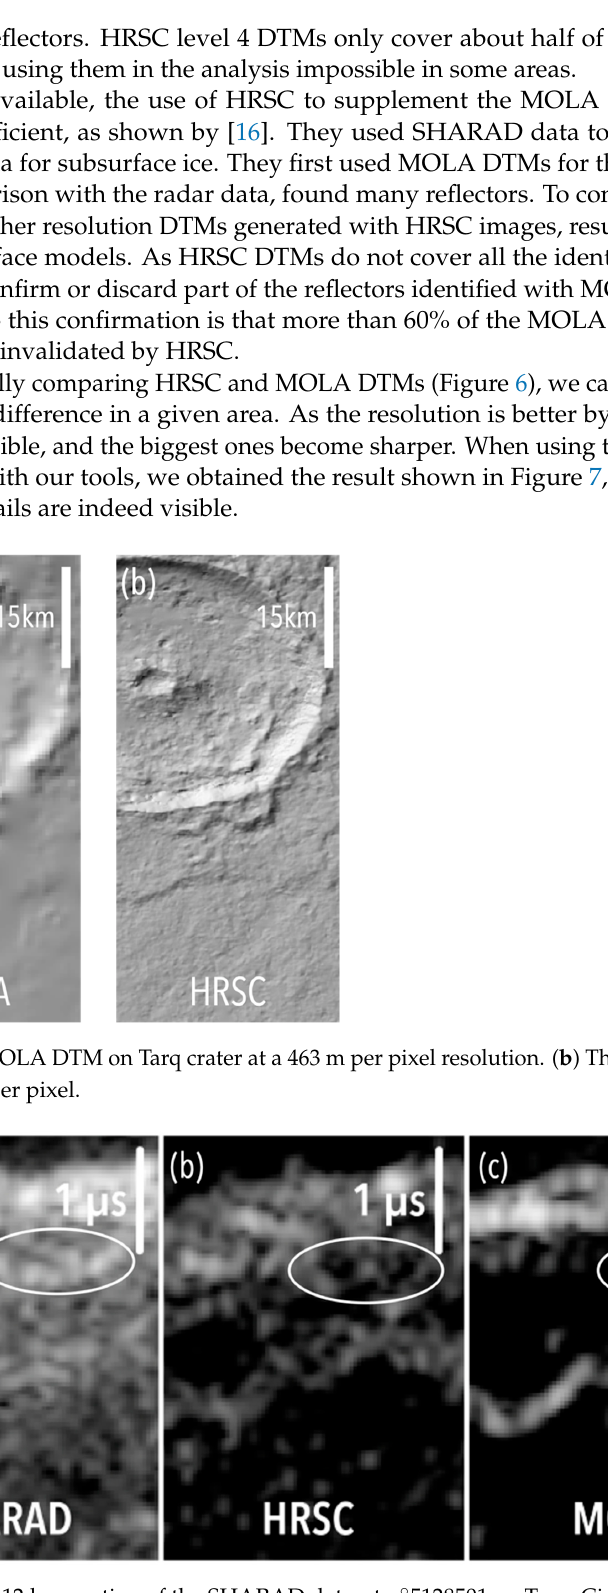
Figure 7. ( a ) A 12 km portion of the SHARAD dataset n°5128501 on Terra Cimmeria. ( b ) Simulation using a HRSC DTM. ( c ) Simulation using a MOLA DTM. Finer details are reproduced by HRSC, but a higher level of artifacts is present. The reflector circled in white is not visible in either of the simulations presented on the two rightmost images.